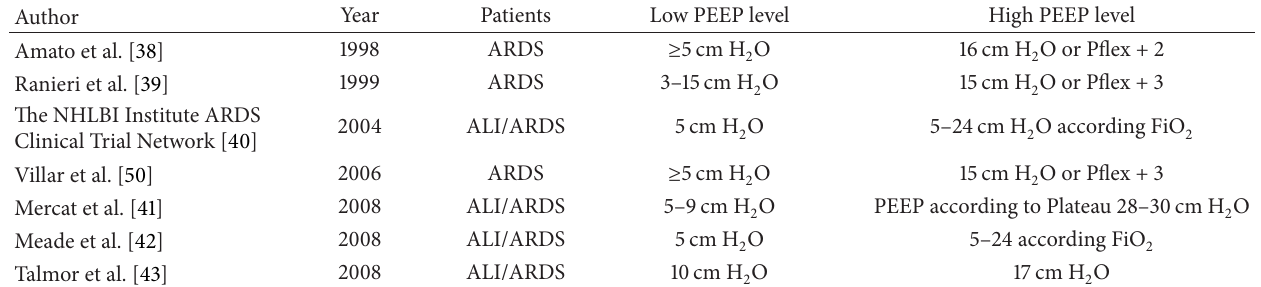
Table 2: Main characteristics of RCTs for ARDS patients included in this study.